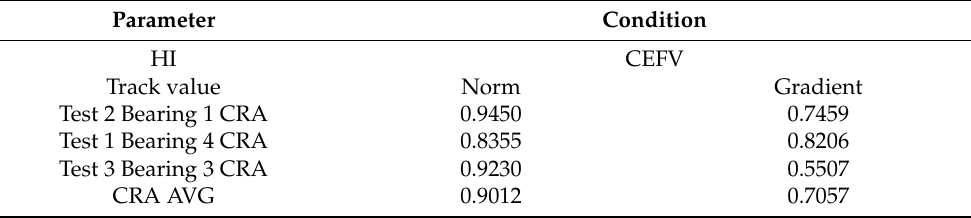
Table 4. IMS data CEFV CRA comparison.